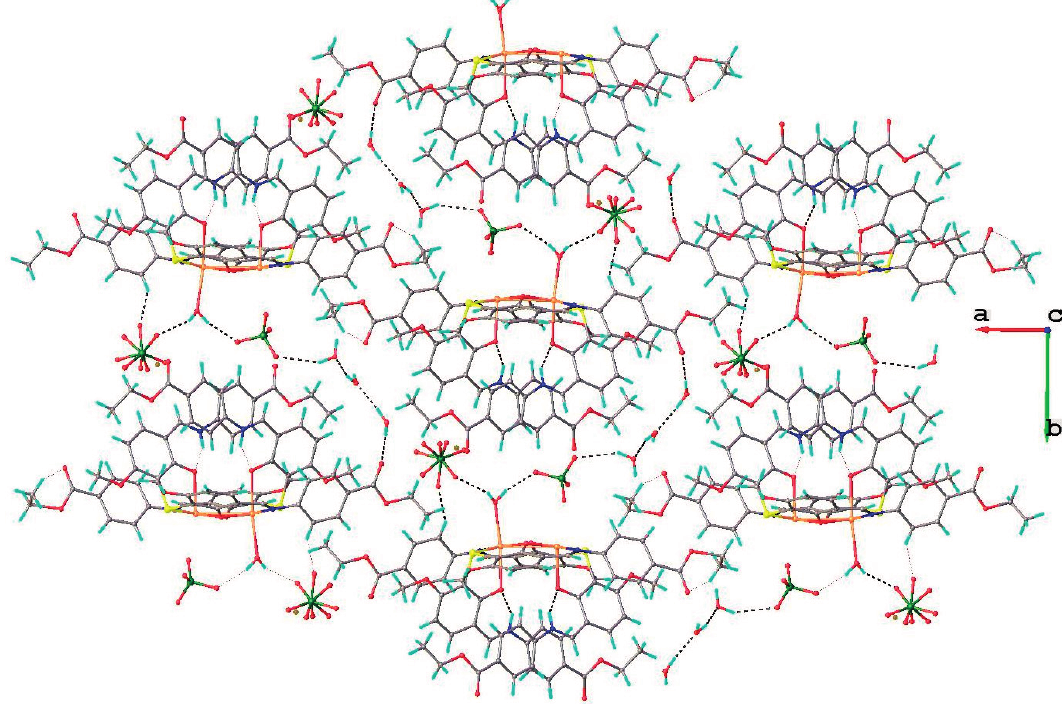
Figure 9. View of 2D supramolecular layer in the crystal structure 6